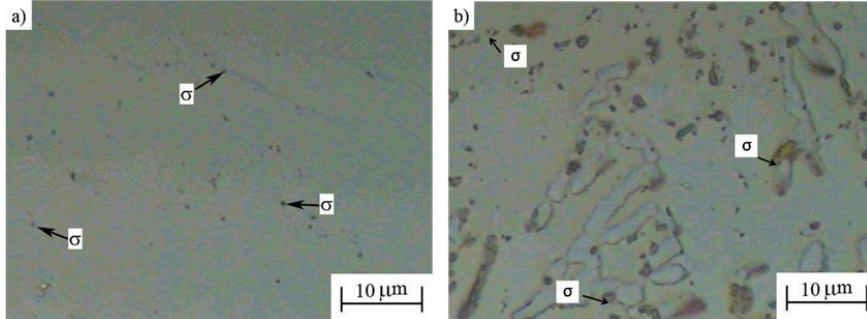
Figure 8. Microstructures of WJ2-WMC obtained by metallographic replica. (a) 15 and (b) 60 minutes. Reagent: KOH.